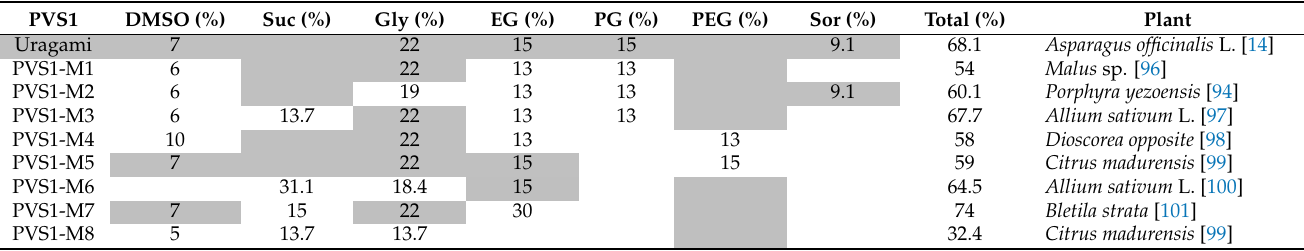
Table 2. The concentration of substances of the original Plant Vitrification Solution numbered one (PVS1) uses Uragami [14]. PVS1 DMSO